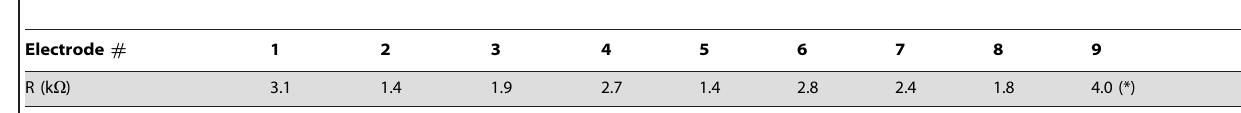
Table 1. Resistivity @100Hz of each electrode/lead.